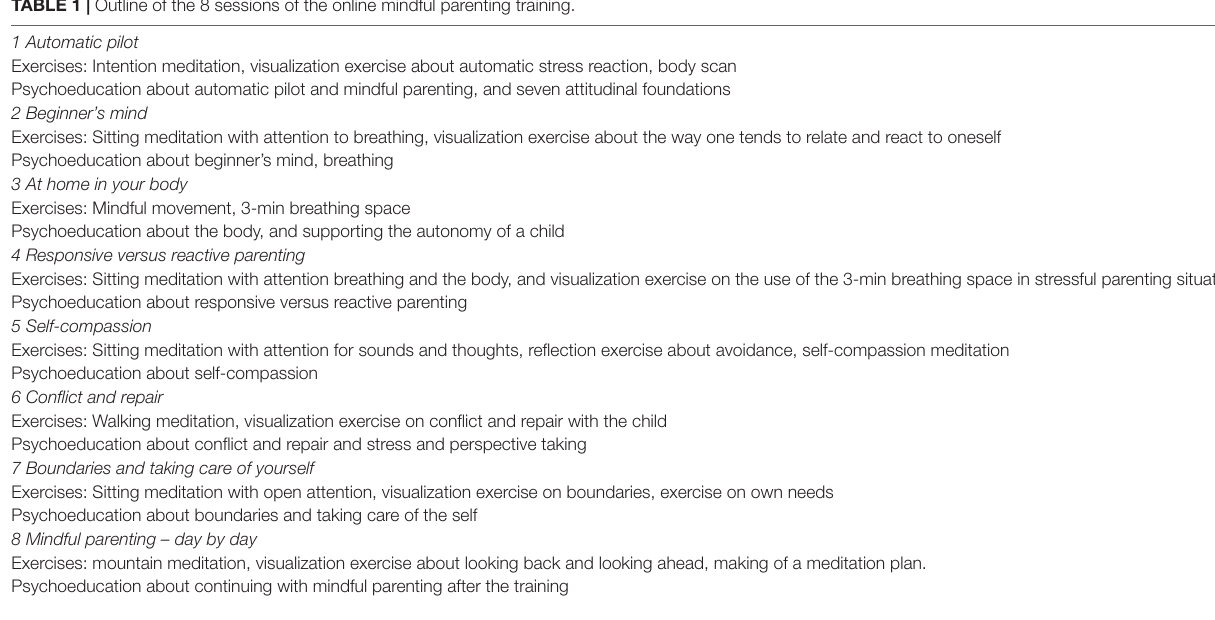
TABLE 1 | Outline of the 8 sessions of the online mindful parenting training. 1 Automatic pilot Exercises: Intention meditation, visualization exercise about automatic stress reaction, body